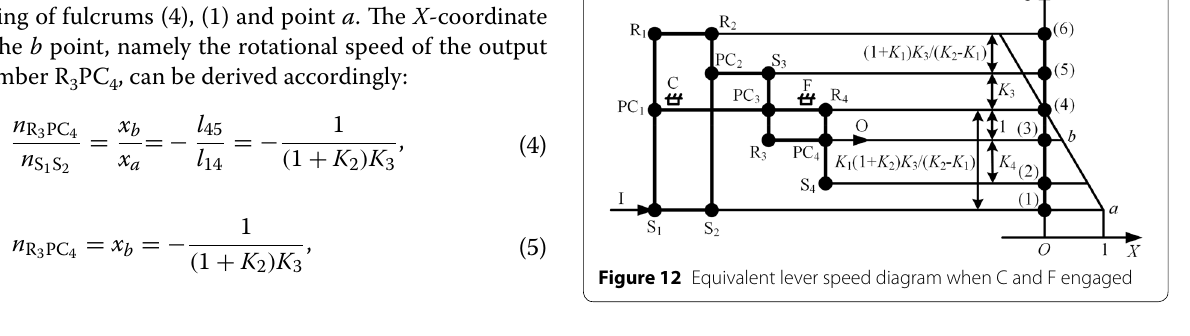
Table 1 Rotational speed of each component when D and F engaged (r/min) Component S 1 S 2 Rotational speed 1